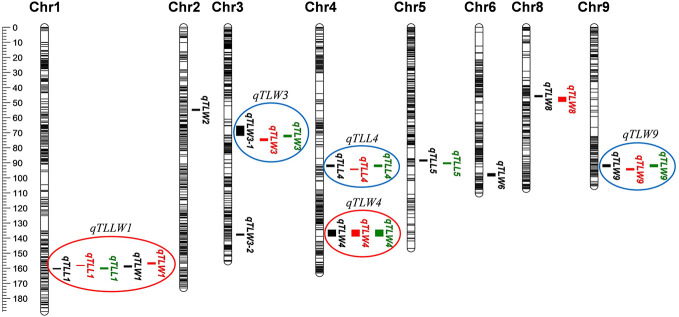
Quantitative trait loci (QTL) analysis of leaf length and width in recombinant inbred lines (RILs). Location of 24 QTLs for leaf length and leaf width. Red circles (major QTLs) and blue circles represent QTLs of repeated detection in both areas, each black line on chromosome indicates a SLAF marker.